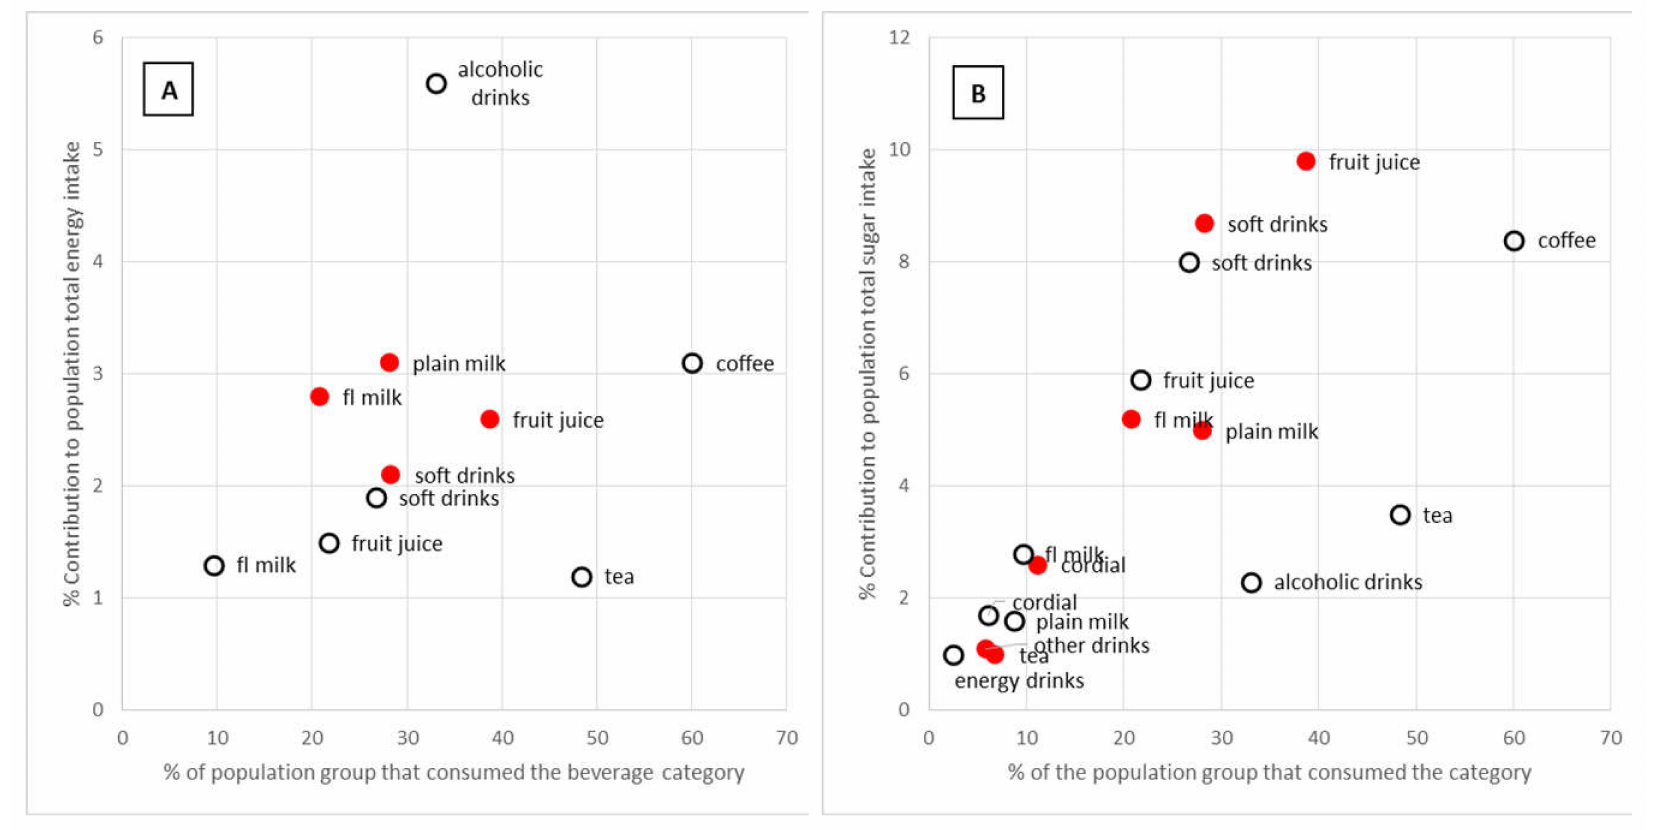
Figure 3. The contribution of beverage categories to ( A ) total dietary energy intake and ( B ) total sugar intake for Australian children (2 to 18 years, ) and adults (19 years and older, ) by the prevalence of consumption on the day of the survey. Only categories contributing 1% or more to the total energy or nutrient intake are